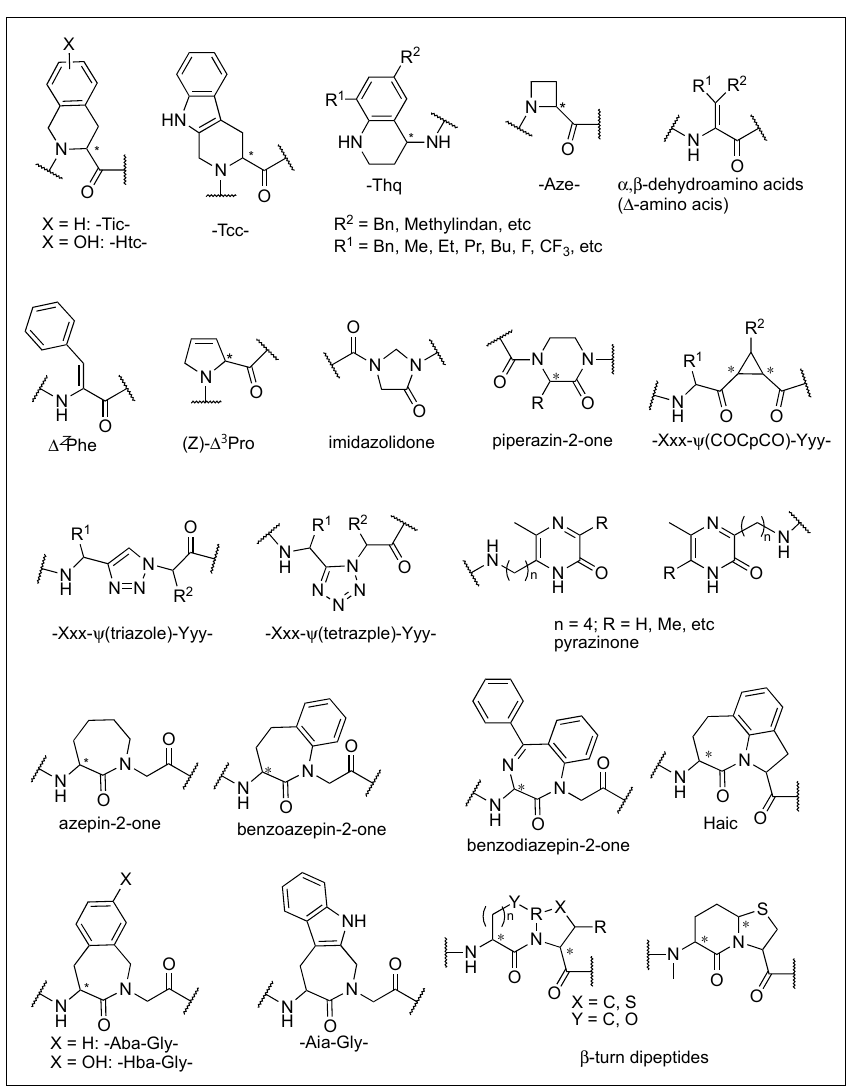
analog of Phe, Tyr, and Trp, respectively, which are key structural elements of most opioid peptides. and Tic has been successfully applied to the design of opioid peptidomimetics (Figure 8). Dmt-Tic is the shortest peptide pharmacophore for DOR antagonism and is being widely used as a template due to the remarkable alterations in selectivity and ac- tivity [180,264,267,268]. 1,2,3,4-tetrahydroquinoline (Thq) derivative coupled with a Dmt residue to resemble JOM-13 structure showed potent MOR agonist activity [269]. Further modifications at C-6 and C-8 positions of Thq with various aromatic, cycloalkyl, hetero- cyclic, and alkyl groups transferred its activity to a mixed opioid activity with optimized pharmacological properties reducing tolerance and dependence as well as improving the BBB permeability [91,270,271]. The modification with 4-hydroxy 2-methylindanyl group at C-6 significantly increased efficacy at KOR ( K i = 0.77 nM, EC 50 = 25 nM, 92% stimulation) and MOR ( K i = 0.18 nM, EC 50 = 4.9 nM, 66% stimulation) resulting in a MOR/KOR agonist [272].